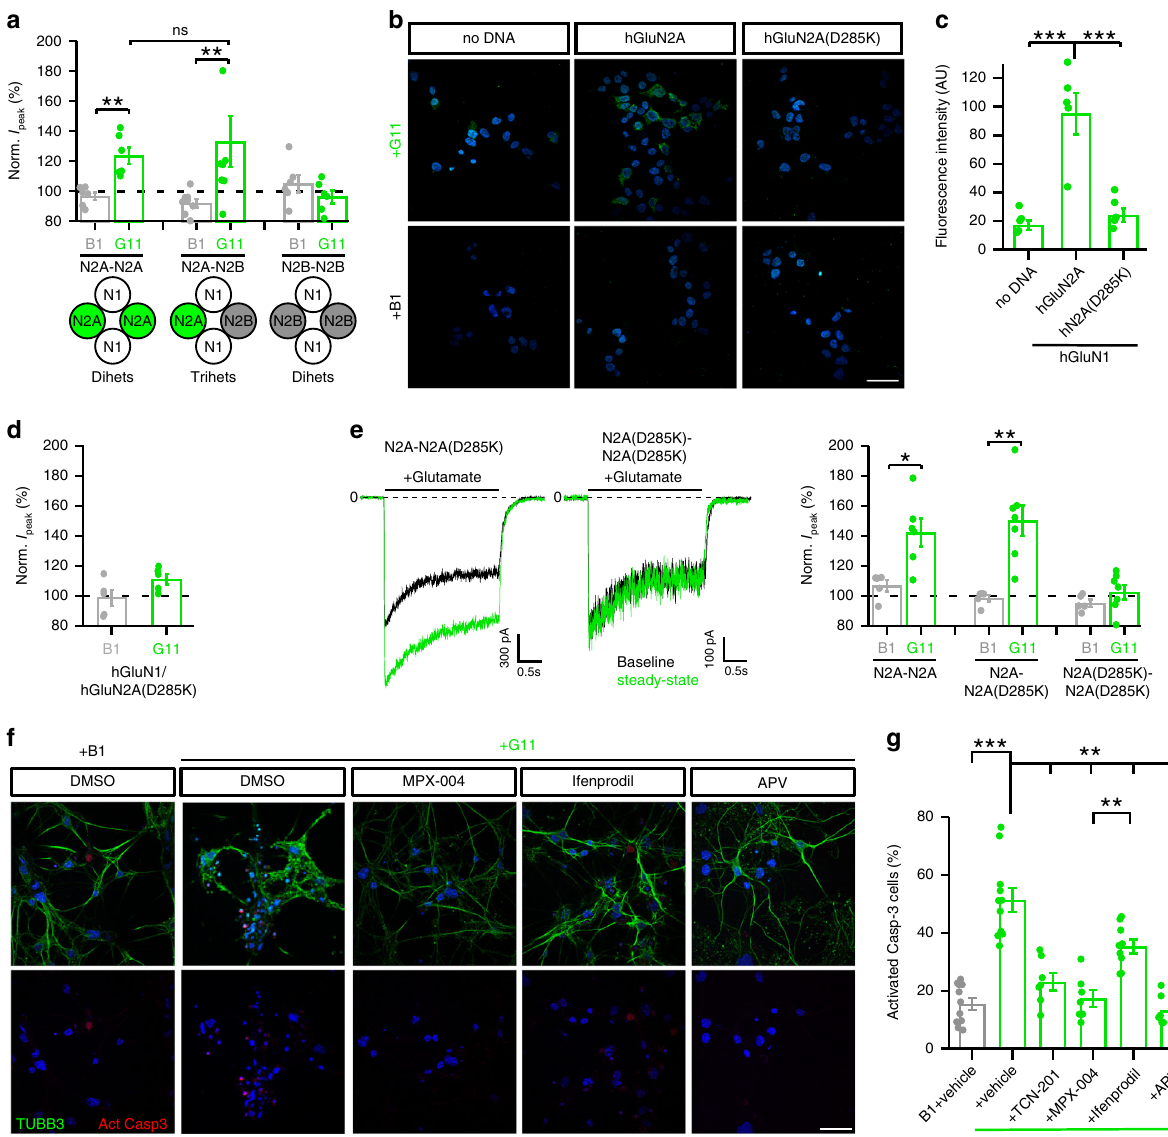
Fig. 3 A single copy of GluN2A confers high sensitivity to SLE DNRAbs. a Bar graphs (mean ± SEM) (left to right, n = 6, 6, 8, 8, 6, 6 cells recorded) showing normalized whole-cell peak current amplitudes for diheteromeric (N1/N2A-N2A or N1/N2B-N2B) or triheteromeric (N1/N2A-N2B) receptors at 10 µ g/mL of B1 or G11 antibody (* *p < 0.01, two-sided Mann – Whitney U test) (left to right, p = 0.00507, 0.00865, 0.298; for ns, p = 0.581). b Representative images from immunocytochemistry of HEK293T cells not transfected (no DNA) or transfected with GluN1/GluN2A or GluN1/ GluN2A (D285K), stained with B1 or G11 (10 μ g/mL) (green, Alexa-488) and DAPI (blue) counterstain. Scale (white bar): 40 µ m. c Mean fl uorescence intensity in (B) (mean ± SEM) ( n = 5 coverslips of cells, all conditions) (* **p < 0.001, one-way ANOVA with post-hoc Tukey ’ s test) (Tukey ’ s: no DNA vs hN2A, p = 0.000156; hN2A vs hN2A(D285K), p = 0.000348). d Single charge reversal prevents DNRAb (10 μ g/mL) potentiation of whole-cell currents (mean ± SEM, n = 5 recorded cells, all conditions). e Left, current records of triheteromeric (N1/N2A-N2A(D285K)) or diheteromeric (N1/ N2A(D285K)-N2A(D285K)) NMDARs. Currents displayed as in Fig. 1a. Right, bar graphs (mean ± SEM) (left to right, n = 5, 6, 5, 7, 5, 6 recorded cells) showing normalized current amplitude for diheteromeric and triheteromeric receptors at 10 µ g/mL of B1 or G11 ( *p < 0.05, ** p < 0.01, two-sided Mann – Whitney U test) (left to right, p = 0.0358, 0.00577, 0.194). f Immunocytochemistry of DIV14 primary hippocampal cultures incubated either in control (B1 + vehicle) or in DNRAb (G11) at 10 µ g/mL. G11 was incubated either alone ( + vehicle), with TCN-201 (not shown), MPX-004, or ifenprodil at 3 µ M. Upper panels, representative images of neurons stained with antibodies against neuronal β -tubulin, Tubb3 (green, Alexa-488), and activated caspase-3 (red, Alexa-647), with DAPI (blue). Lower panel, only activated caspase-3 channel. Scale (white bar): 40 µ m. g Quanti fi cation of immunocytochemistry shown in ( f ). Proportion of DAPI and activated caspase-3-positive cells divided by total DAPI cells (mean ± SEM) (left to right, n = 11, 11, 7, 7, 9, 6 coverslips of cells) per treatment condition ( *p < 0.05 ,**p < 0.01, *** p < 0.001, one-way ANOVA with post-hoc Tukey ’ s test) (Tukey ’ s: G11 + vs G11 + MPX-004, p =